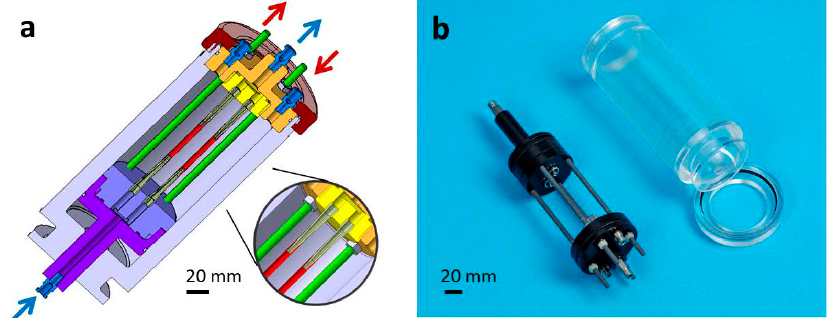
Figure 9. ( a ) Sectional view of the seeding cylinder with scaffolds (red), inlet (purple and violet), outlet (orange and yellow), spacers (green), Luer-Lock adapters (blue), housing (grey) and screw cap (brown); ( b ) final implementation of the seeding